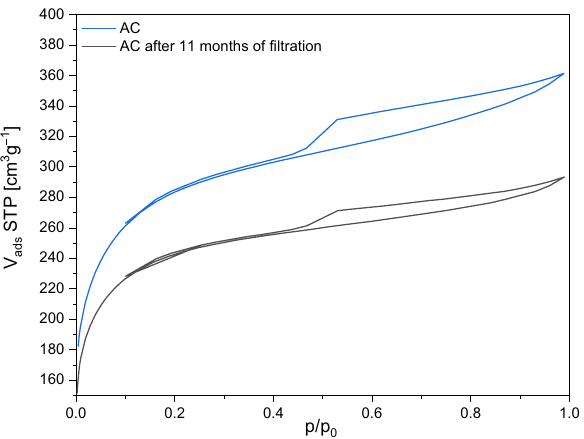
Figure 8. N 2 adsorption–desorption isotherms of AC activated carbon before and after 11 months exploitation.